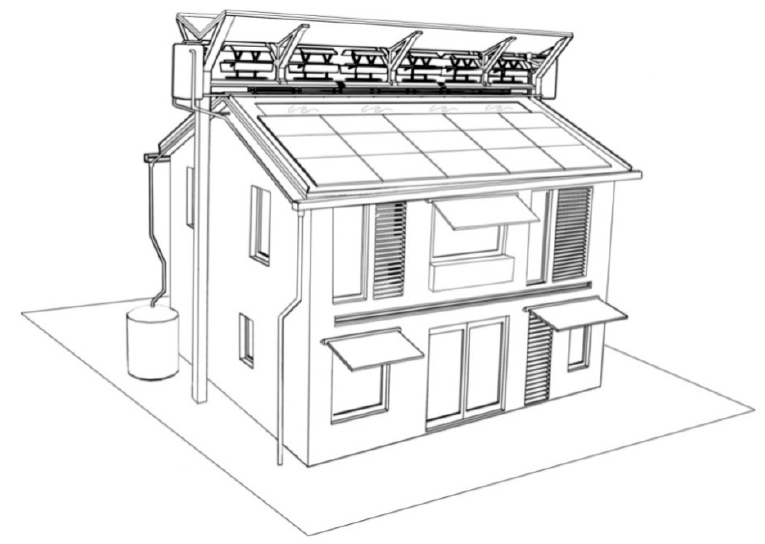
Figure 18. Harvester installation on a building.